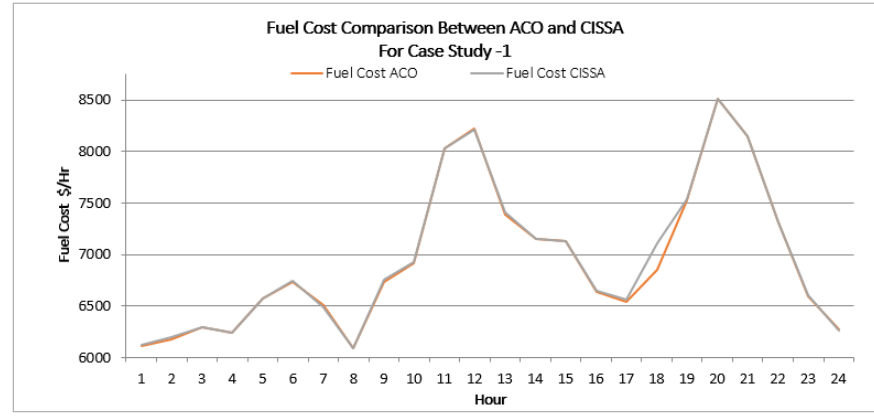
Table 6. Difference in total daily fuel costs — case study 1 .